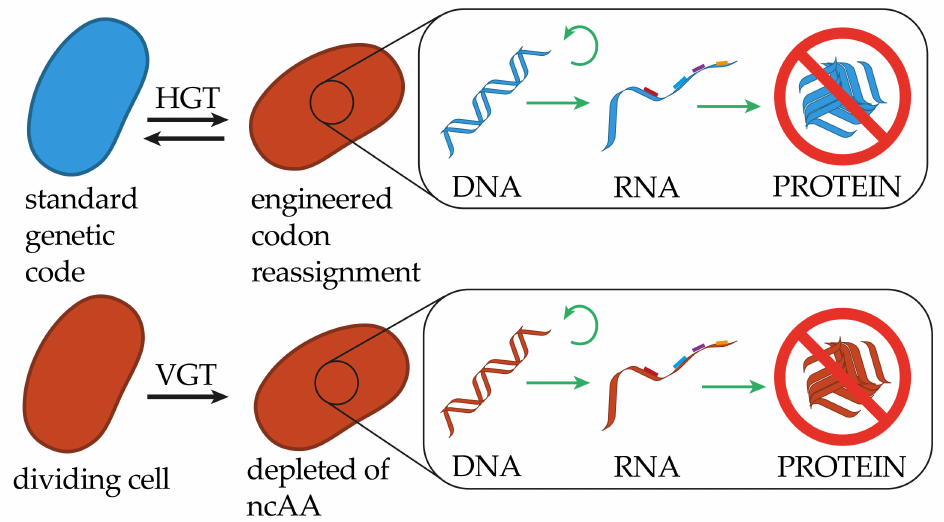
Figure 2. Restrictions of genetic information transfer in altering the meaning of the genetic code. In altering the codon assignment, cells receiving genetic information will be able to truthfully replicate, transcribe and translate the encoded information, however, the resulting polypeptides will not be functional. The same holds true for the genetic information transfer from genetically modified organisms (GMOs) to cells maintaining a standard genetic code. An engineered organism with a strict dependency for a non-canonical amino acid (ncAA) will not be capable of VGT in the absence of the